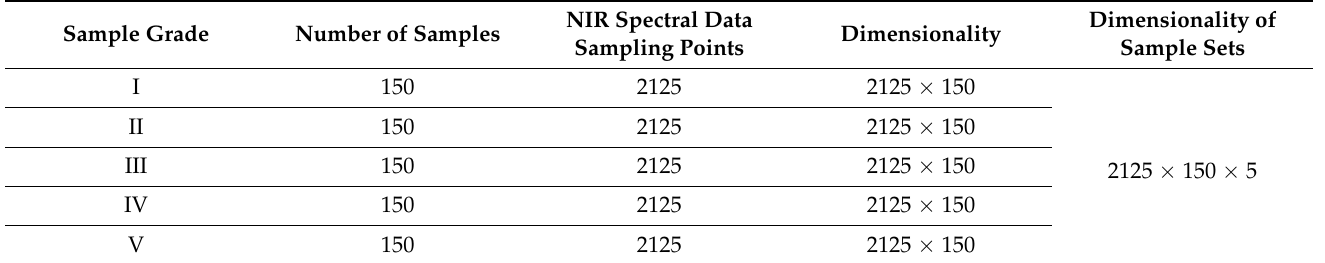
Table 1. Sample set information identified by professional